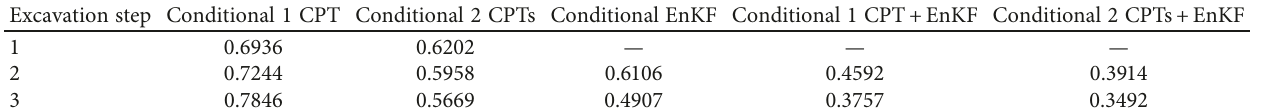
Table 2: Uncertainty reduction ratio u i